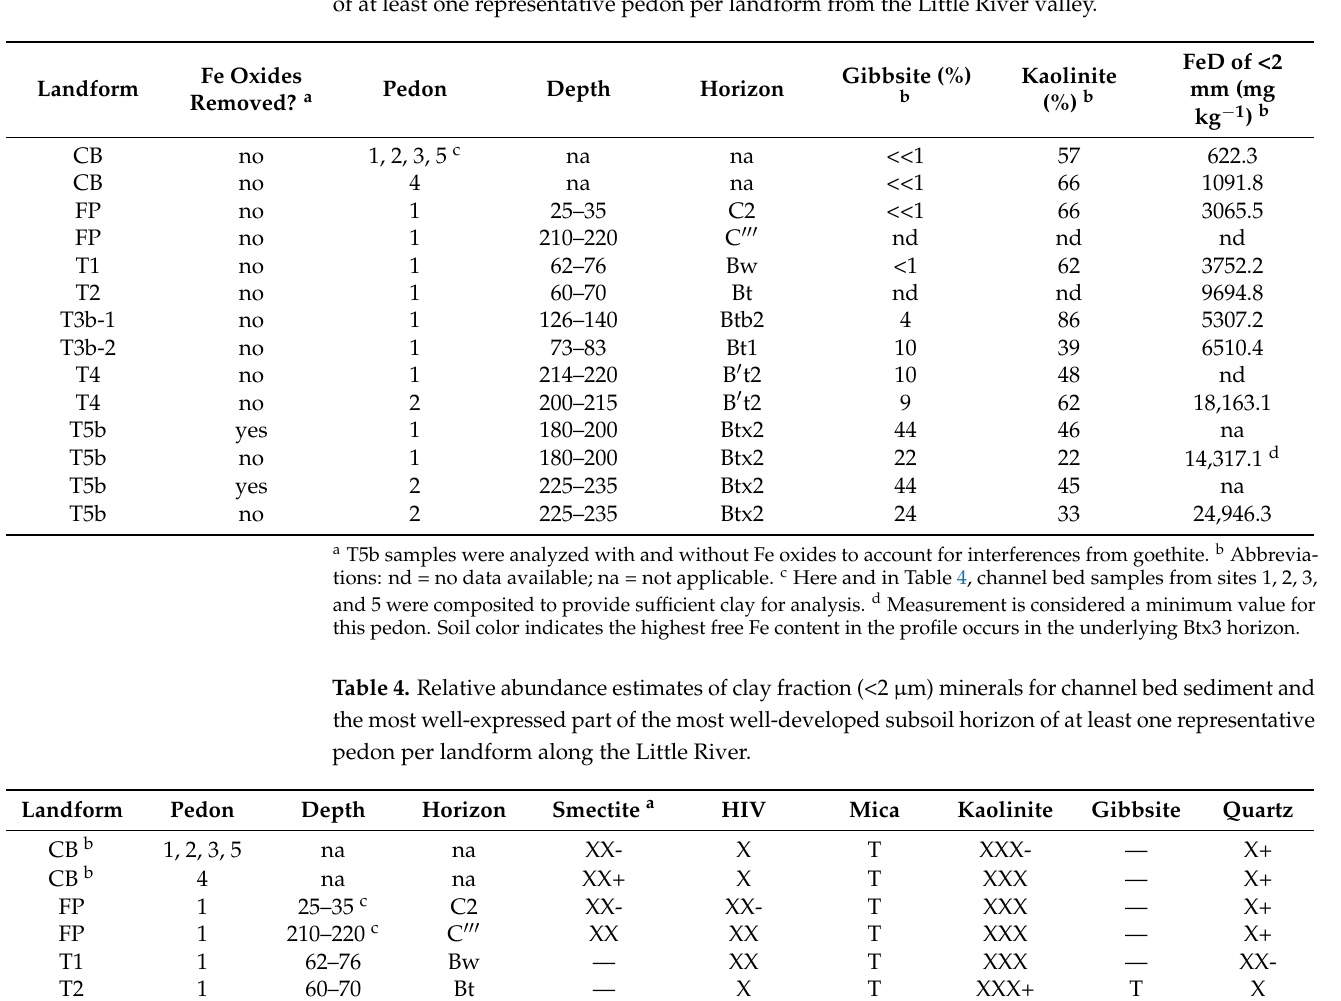
Table 3. Percentages of clay fraction (<2 µ m) gibbsite and kaolinite determined by differential scanning calorimetry (DSC) for channel bed sediment and the most well-developed subsoil horizon of at least one representative pedon per landform from the Little River valley.